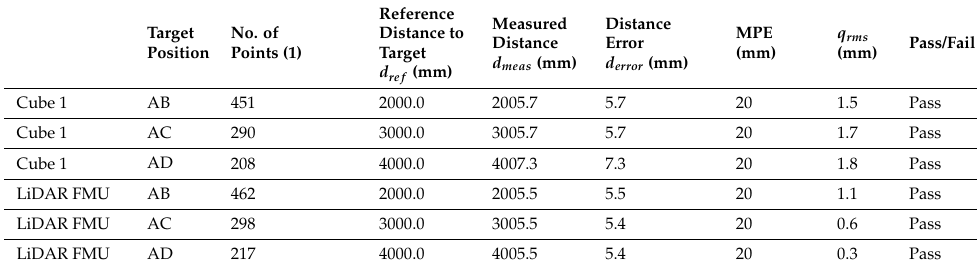
Table 6. Results of relative range